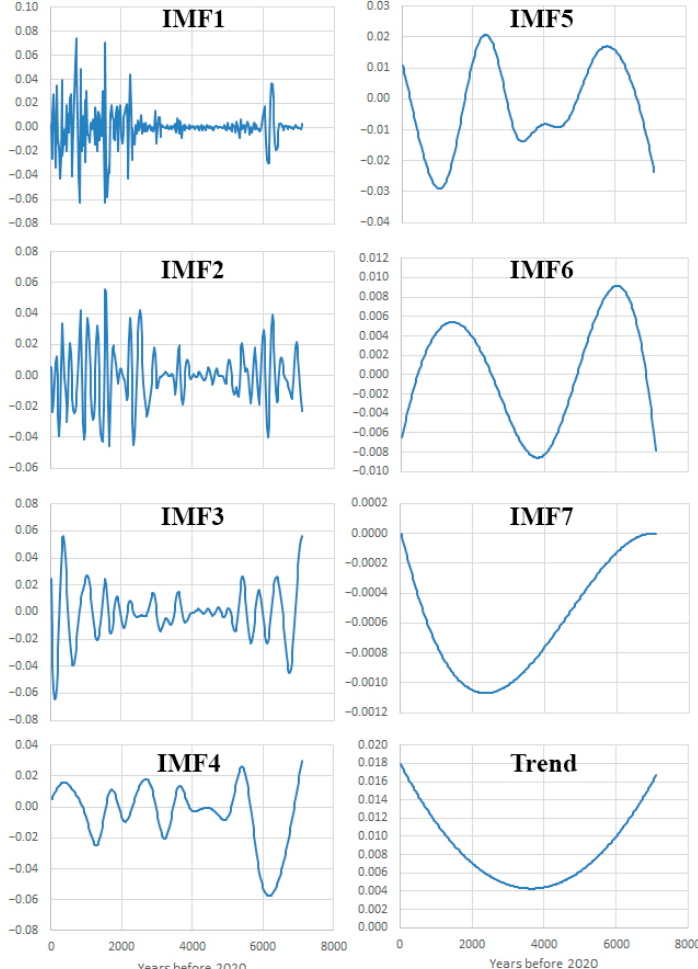
Figure 7. E EMD of the detrended reconstructed humification timeseries in seven IMFs and a Figure 7. EEMD of the detrended reconstructed humification timeseries in seven IMFs and a trend. trend.